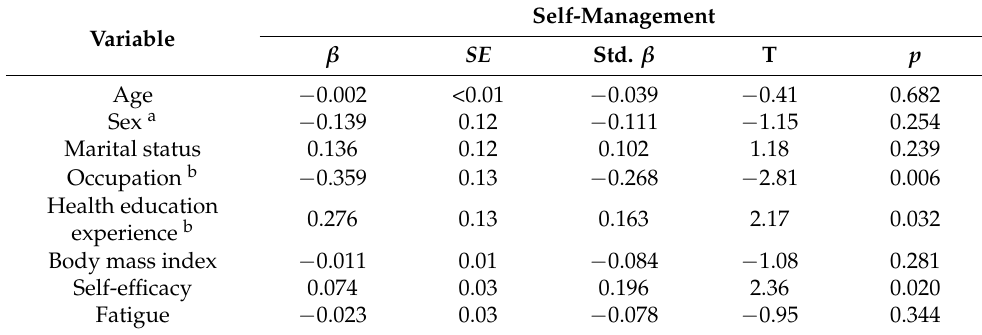
Table 5. Factors associated with self-management among patients with